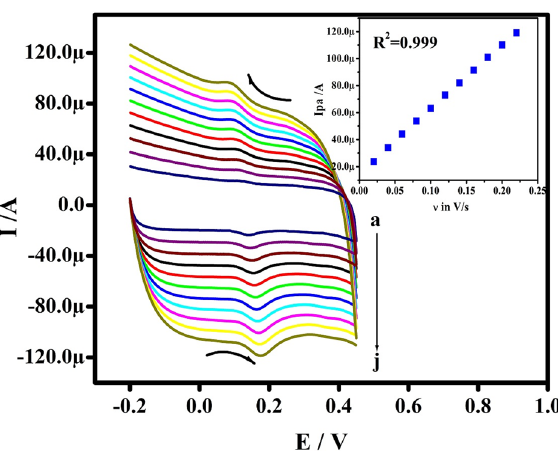
Figure 7. CVs of 5 μM DOA in 0.2 M PBS of pH 7.4 at Po-RD/Al-ZnO MCPE at numerous speed rates ( a – j ; 20–200 mV s −1 ). Inset graph is Ipa v/s υ.